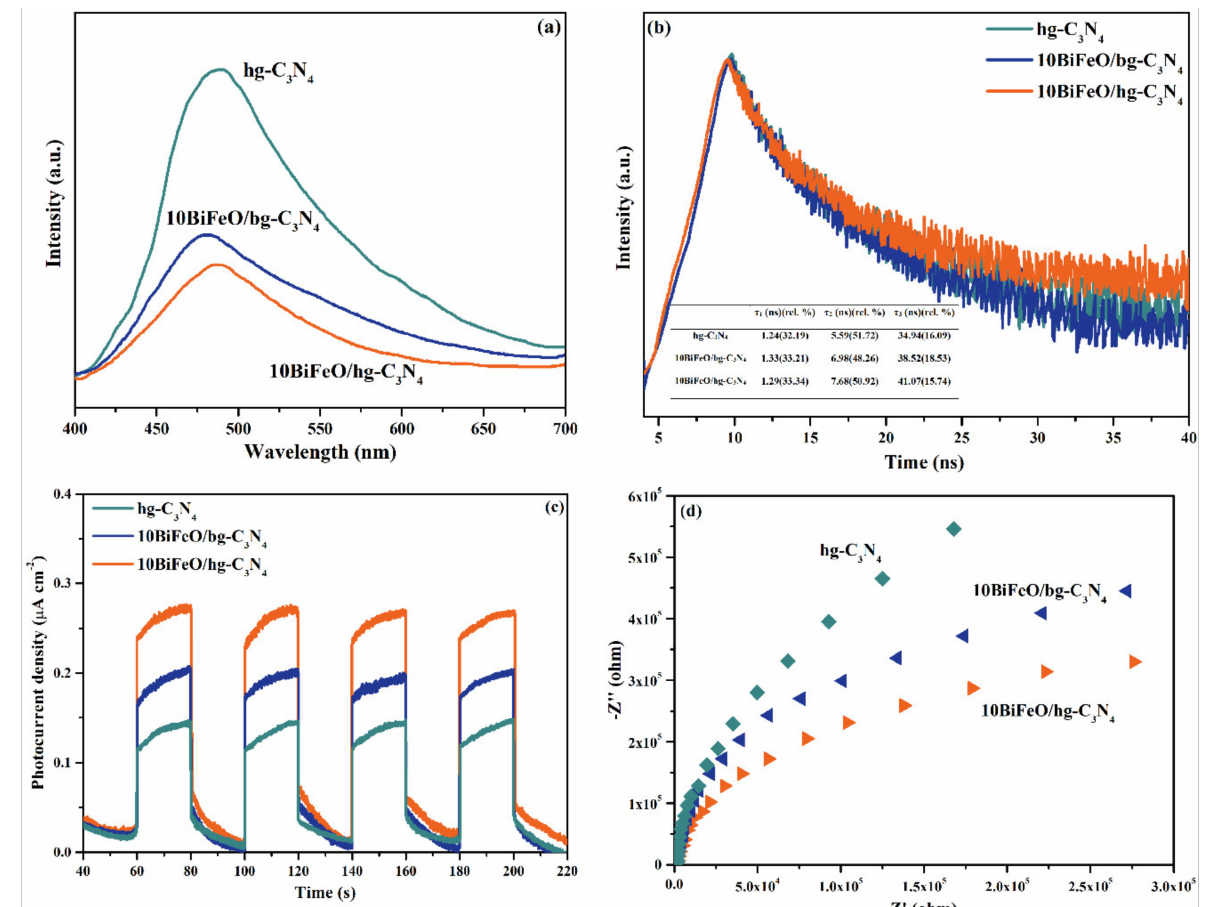
Figure 9. Steady-state PL spectra ( a ), time-resolved PL spectra ( b ), photocurrent response density ( c ) and EIS Nyquist plots ( d ) of hg-C 3 N 4 ,10BiFeO/hg-C 3 N 4 and 10BiFeO/bg-C 3 N 4